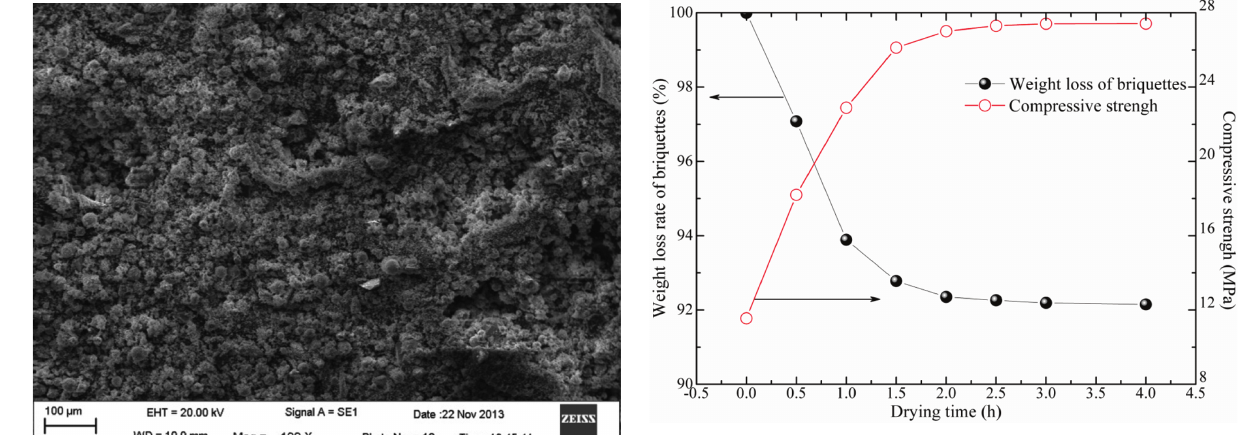
Figure 6: Effect of drying time on compressive strength and weight loss of